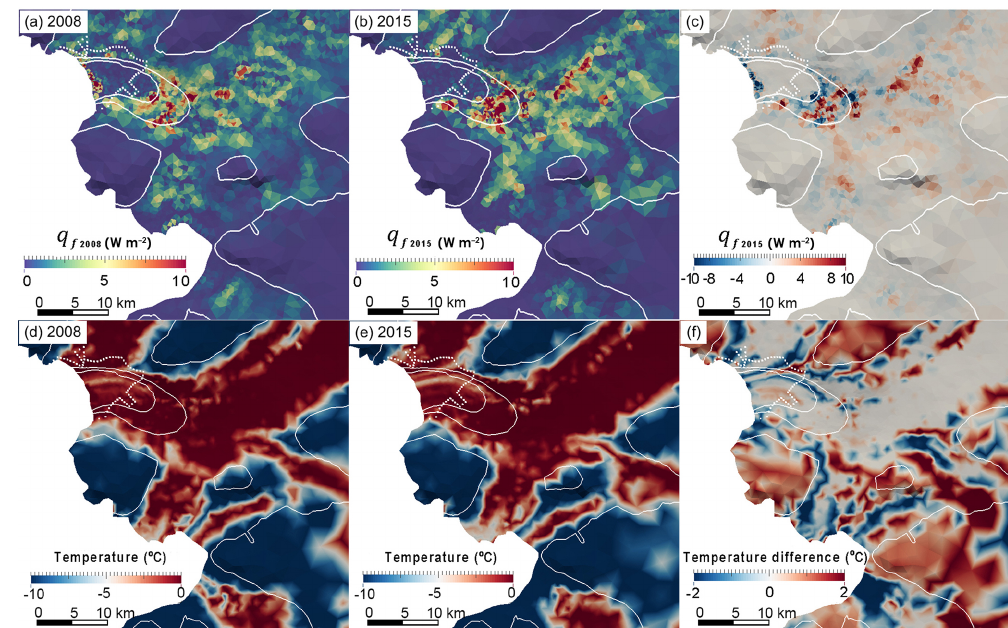
Figure 4. (a, b) The basal friction heating, and (d, e) the simulated temperature relative to the pressure melting point at the base of the Fleming Glacier and the Prospect Glacier in 2008 (a, d) and 2015 (b, e) . The differences of (c) basal friction heating and (f) simulated basal temperature between 2008 and 2015 (2015 minus 2008). The white dotted line represents the deduced grounding line in 2014 from Friedl et al. (2018). The white solid lines represent the 2008 surface speed contours of 100, 1000, and 1500myr − 1